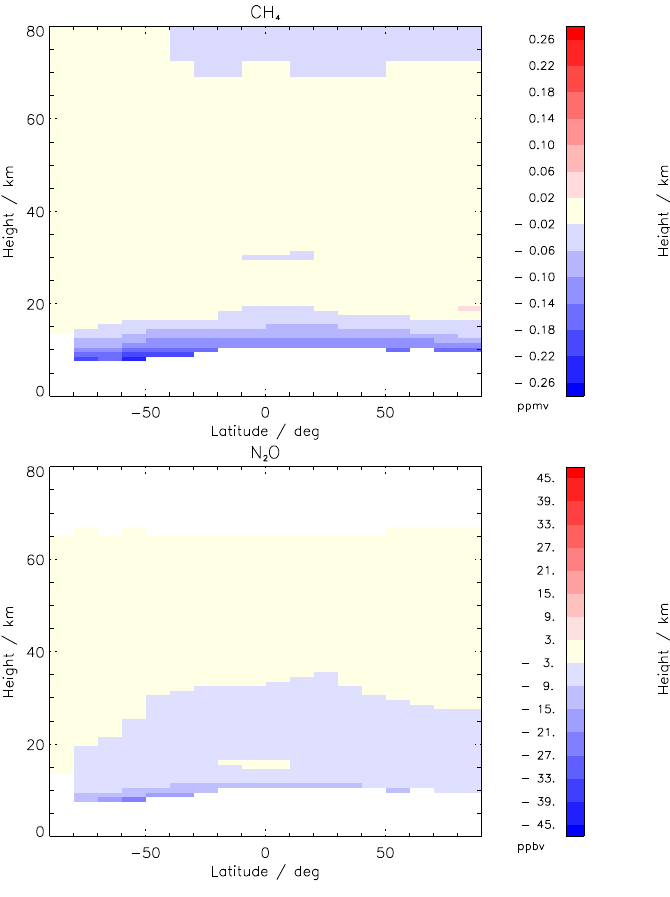
1 Figure 4. As Fig. 3, but difference retrieval with new offset and 1 Figure 3. Zonal mean difference distributions. Difference calcula- continuum setup minus reference with old tion with HITRAN 2008 spectroscopy of CH 4 and N 2 O minus cal- culation with older spectroscopic data sets (for details see text). The upper panel shows results for CH 4 ; the lower panel shows results for N 2 O.